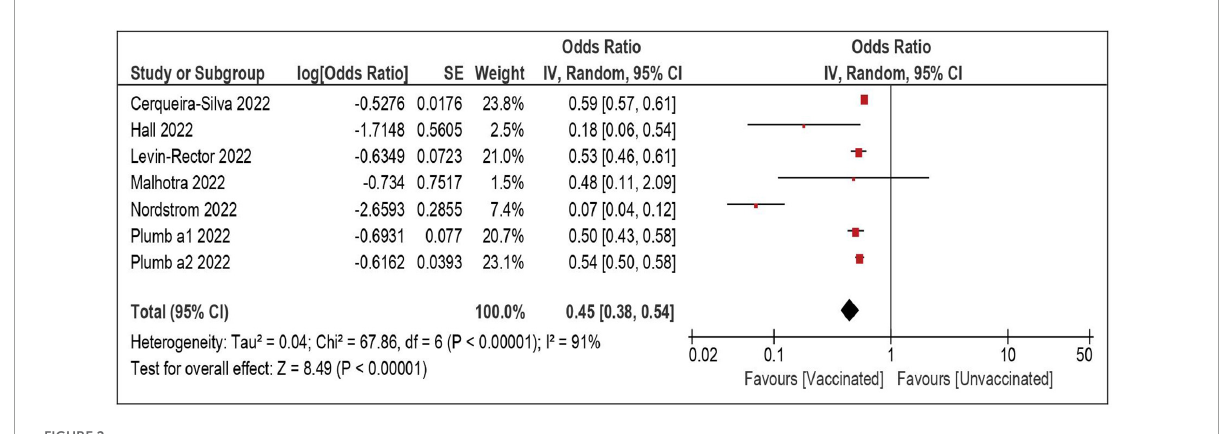
FIGURE2 Risk of severe/lethal COVID-19 among vaccinated vs. unvaccinated